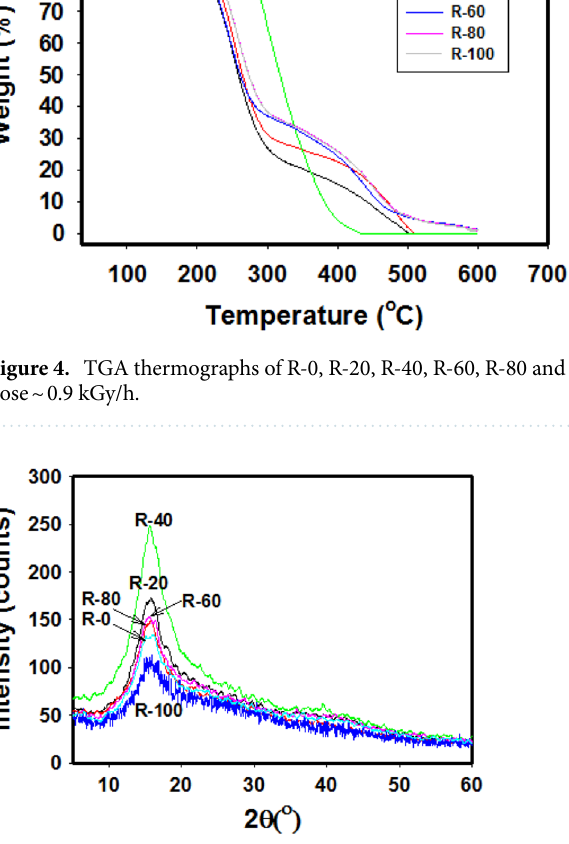
Figure 5. XRD patterns of R-0, R-20, R-40, R-60, R-80, and R-100 samples at different irradiation doses and a fixed dose rate of ~ 0.9